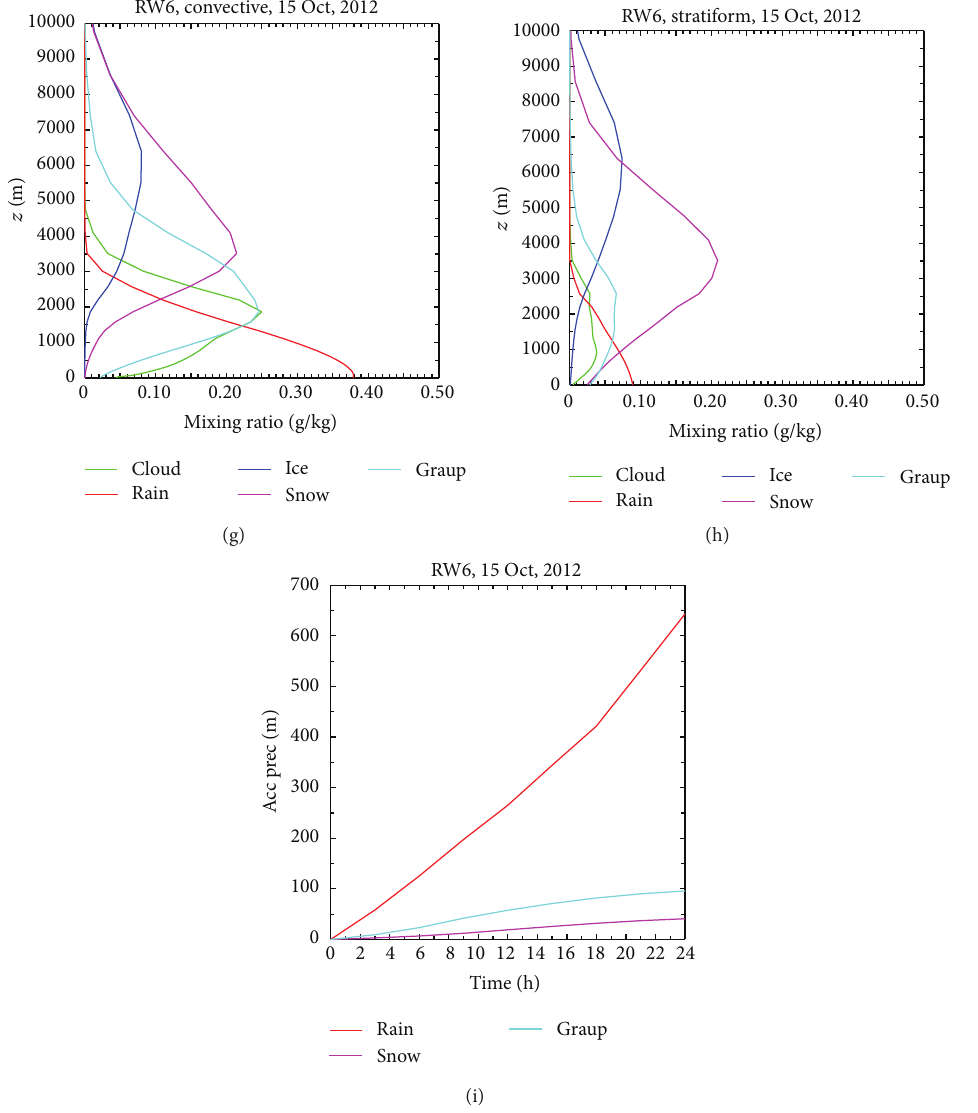
Figure 4: (a) Averaged mixing ratios (g/kg) for R 6 hydrometeors for the convective region; (b) averaged mixing ratios (g/kg) for R 6 hydrometeors for the stratiform region; (c) accumulated precipitation over the whole domain for different hydrometeors for R 6; (d)–(f) as in (a)–(c) but for RW5; (g)–(i) as in (a)–(c) but for